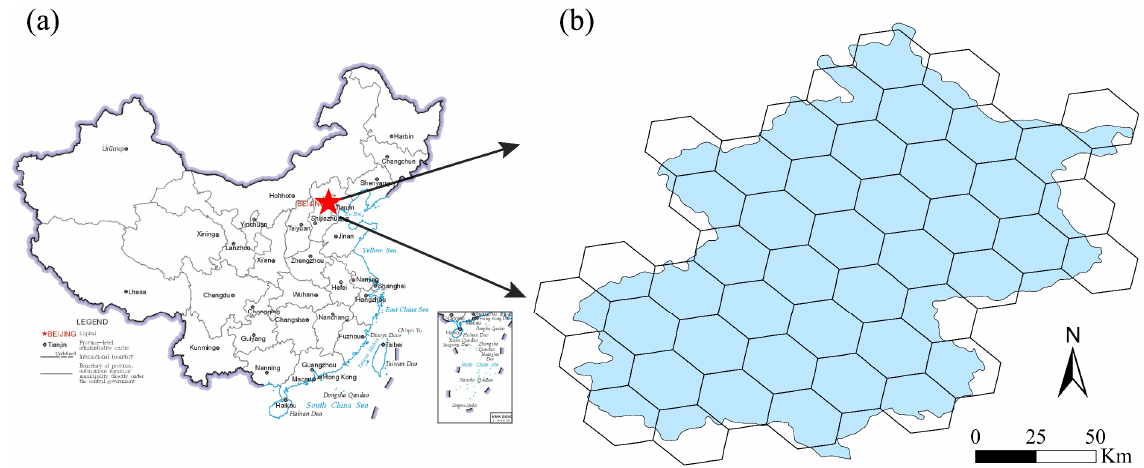
Figure 7. Hexagonal grid fitting of Beijing: ( a ) The map of China; and ( b ) Boundary map of the study